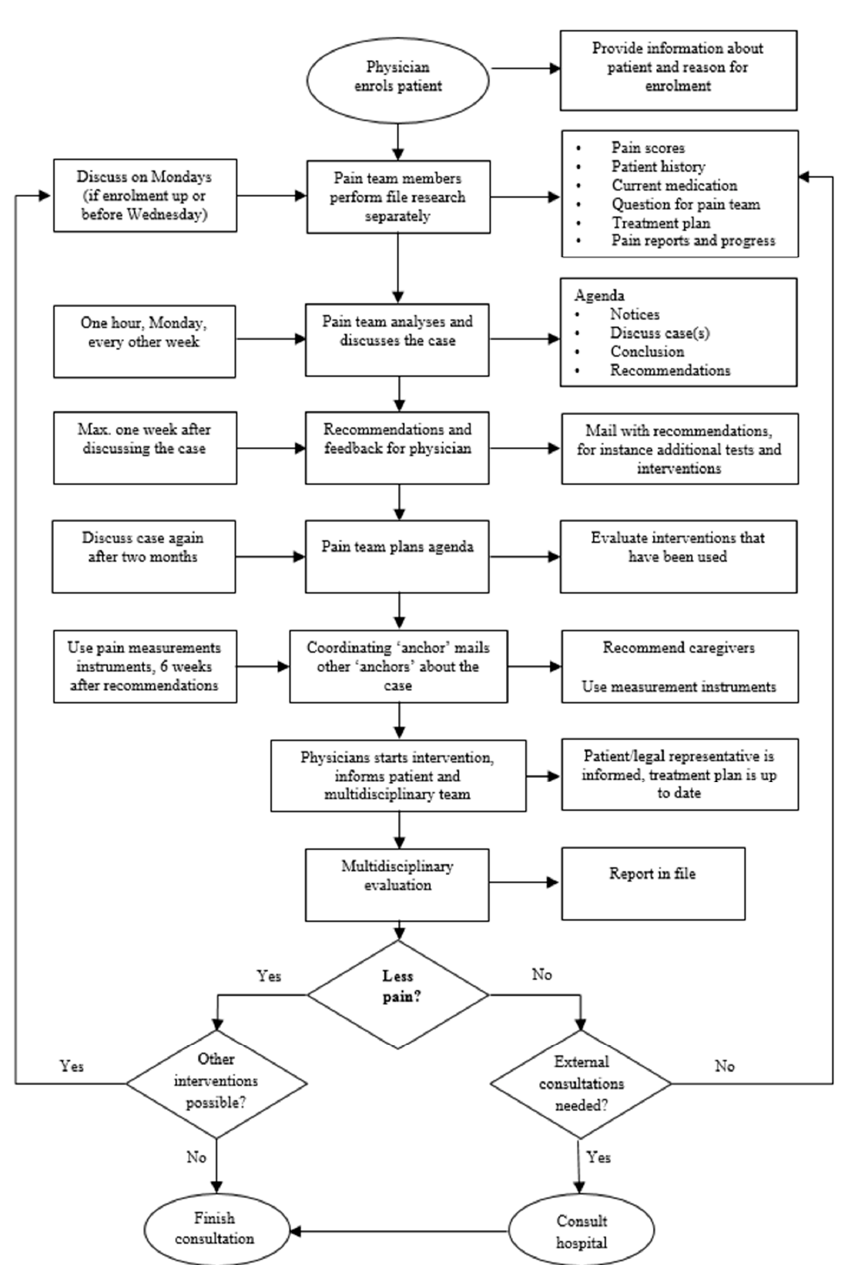
Figure 1. Work flowchart used by the pain team